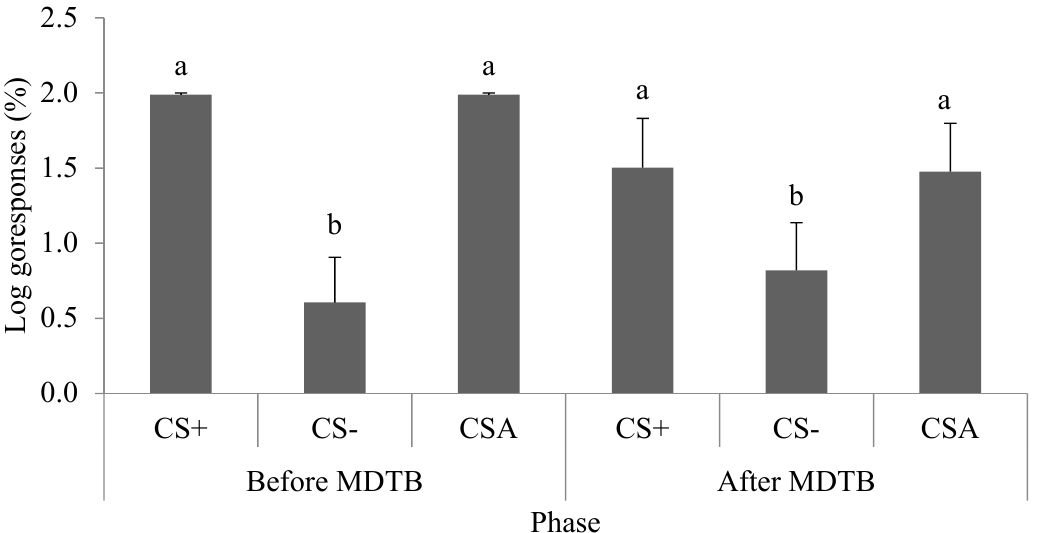
Figure 7. “Go” responses (%) after cues throughout the judgment bias tests performed before and after the modified defence test battery (MDTB). CS+, positive auditory cue; CS-, negative auditory cue; CS A , “ambiguous” auditory cue. Bars with different superscripts are significantly different according to Tukey post-hoc tests.